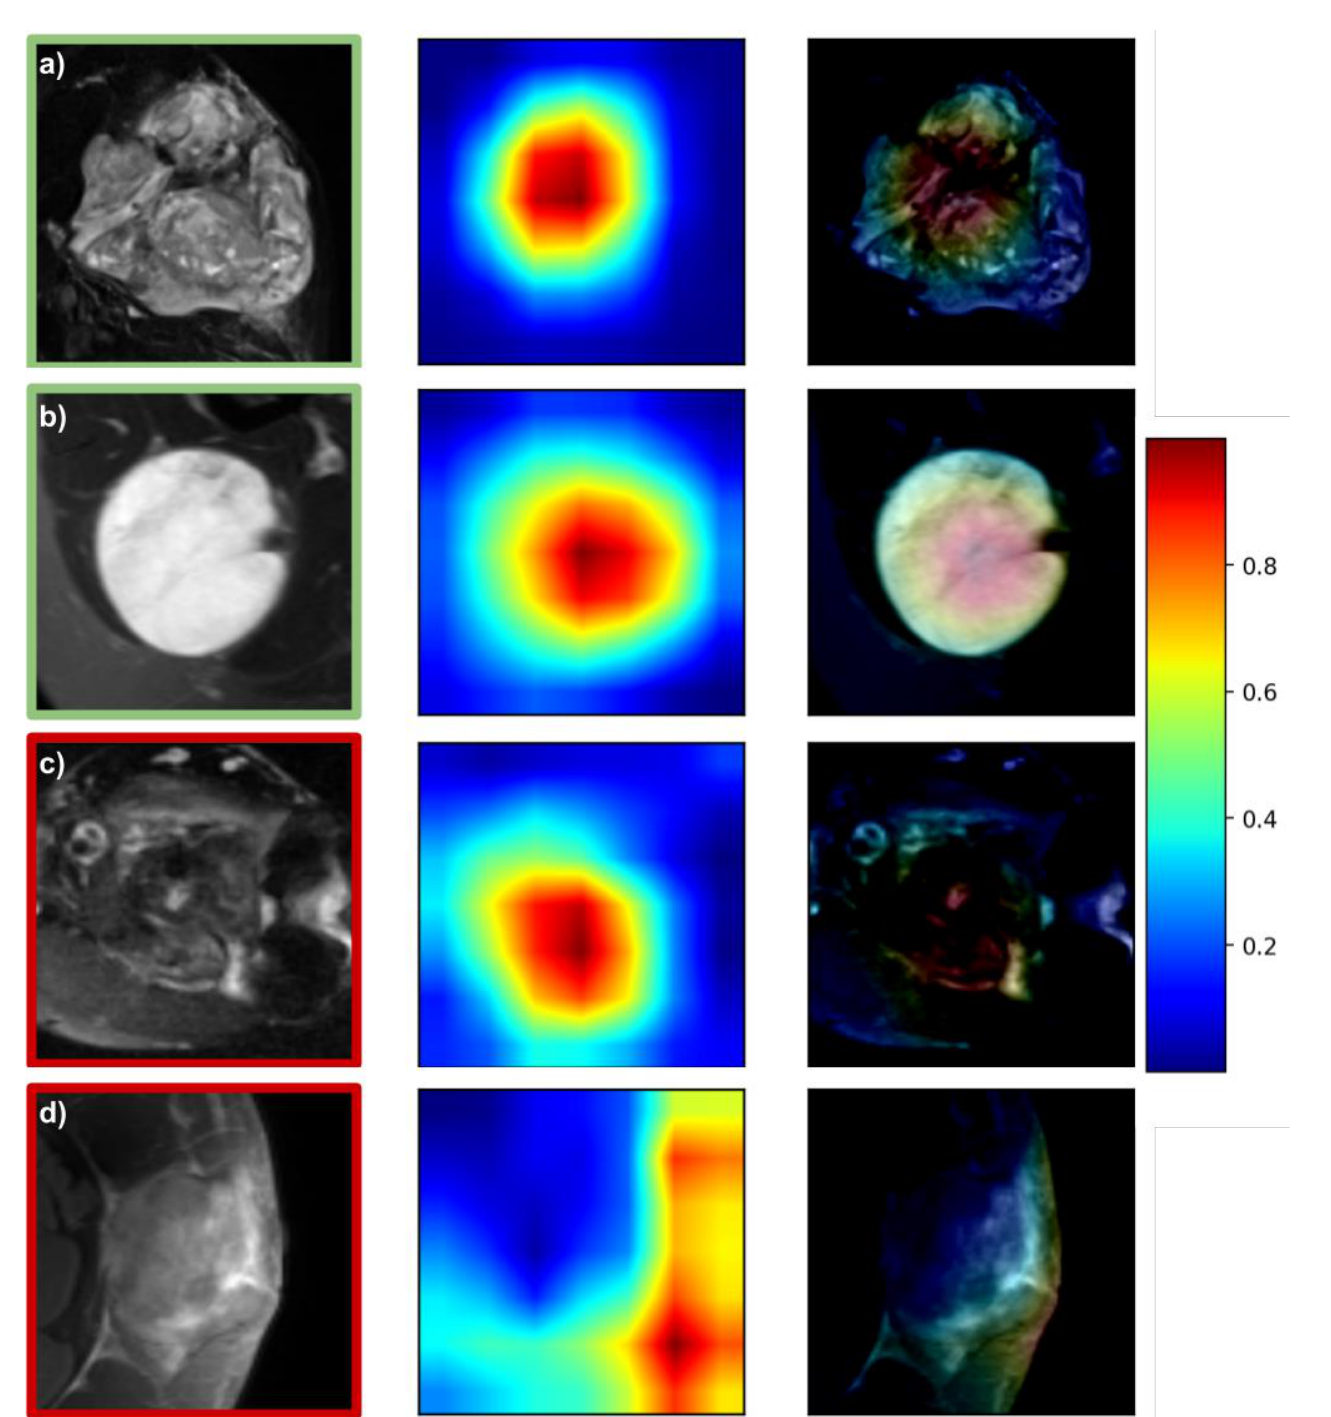
Figure 5. Attention maps of the DL-T2FS model. Green and red squares around images denote correct and false predictions, respectively: ( a ) correct prediction with 99% probability: high-grade (G3) spindle cell sarcoma — focus on tumor texture; ( b ) correct prediction with 97% probability: low-grade (G1) myxoid liposarcoma — focus on tumor texture; ( c ) false prediction with 52% probability: low-grade (G1) myofibrosarcoma — focus on tumor texture; ( d ) false prediction with 97% probability: high-grade (G3) pleomorphic sarcoma — trunk location, focus on air.